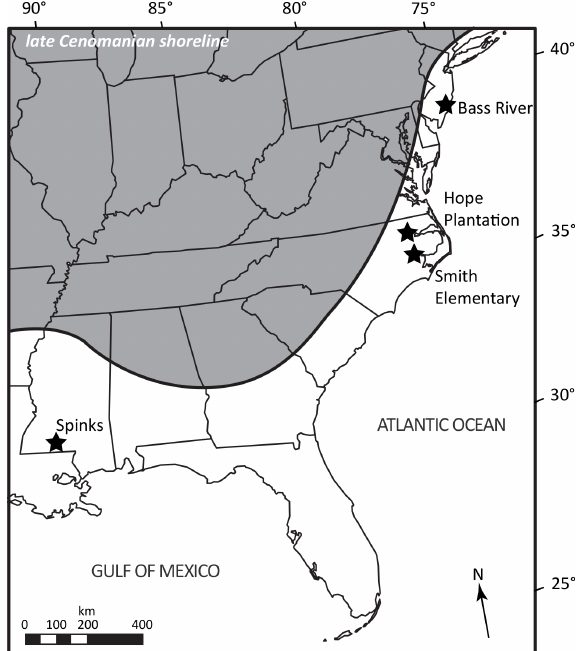
Figure 1. Map of southeastern North America showing the approx- imate late Cenomanian shoreline (land: gray) and the location of the cores discussed in this study. Shoreline position after Slattery et al. (2015) and Snedden et al.